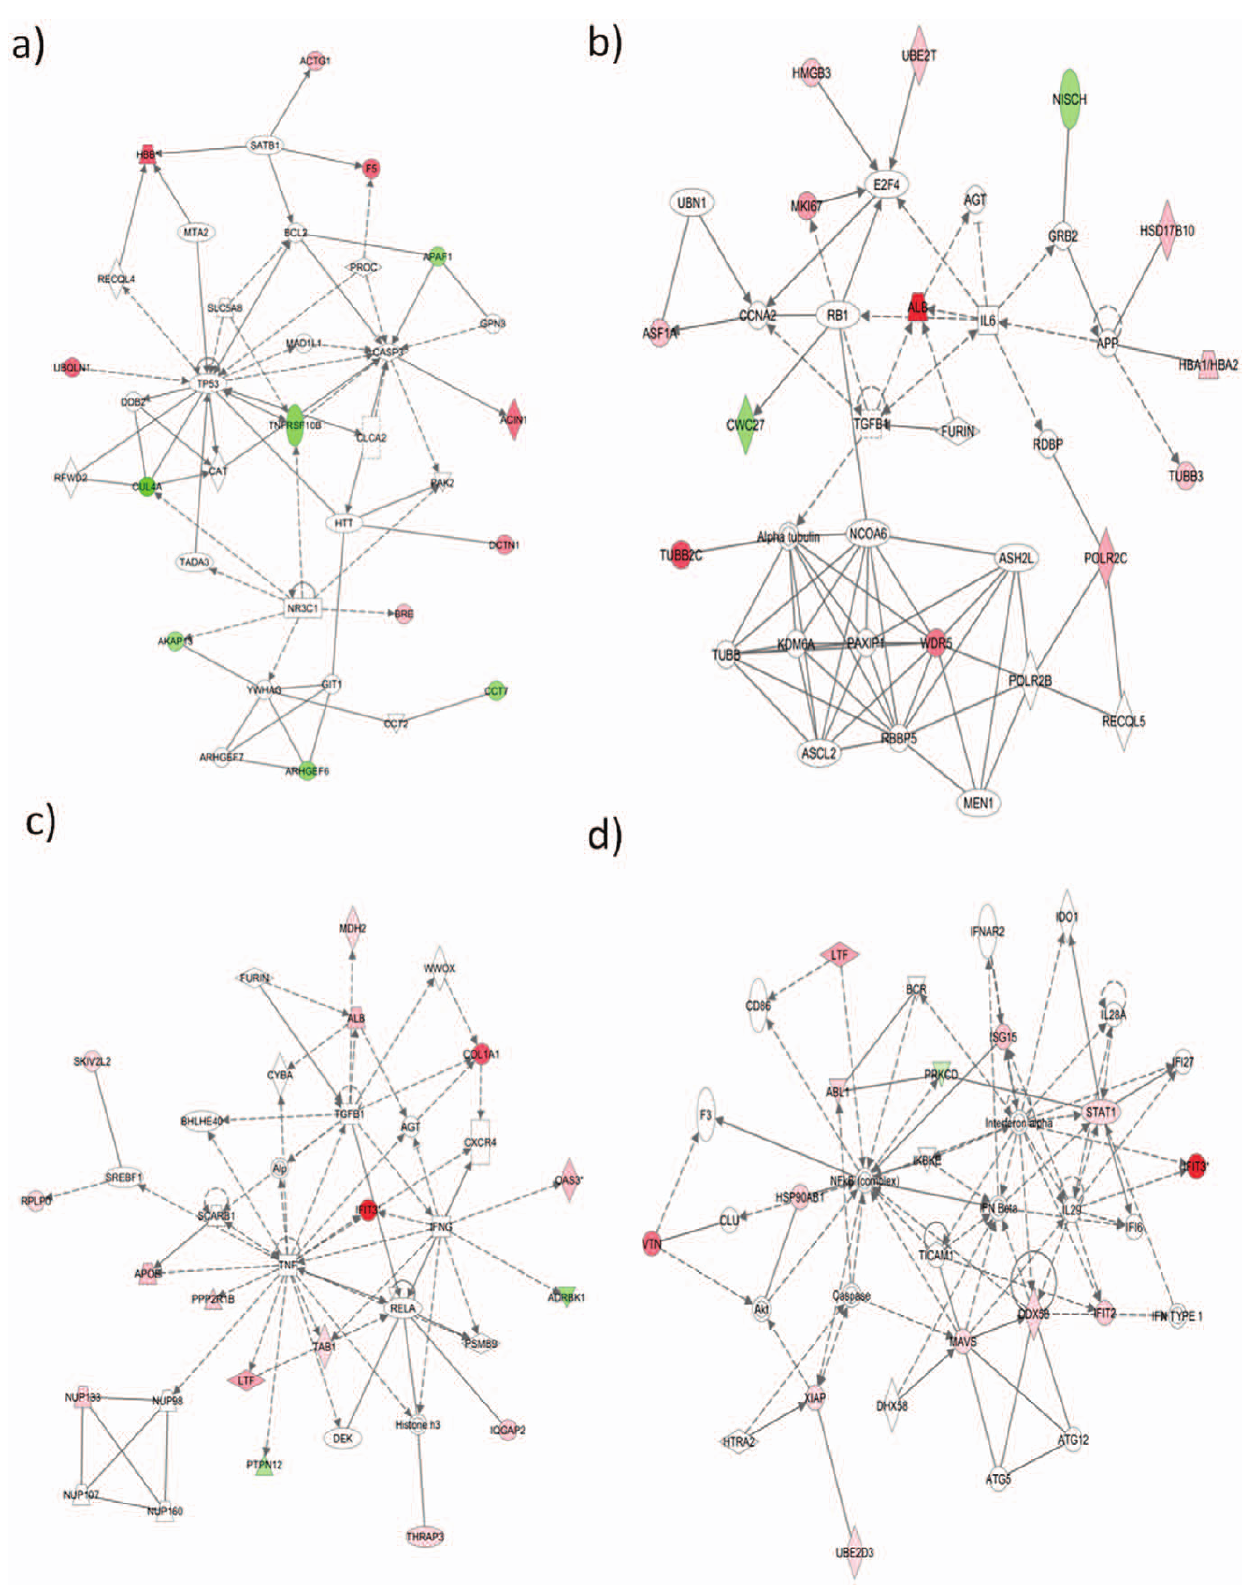
Figure 6. Functional network analysis of differentially regulated proteins observed in T1L infected HEK293 cells at 6hpi (a, b) and 24hpi (c, d). The top network functions identified in the previous figure are shown in more detail with interconnecting protein relationships indicated by solid (direct interaction) or dashed (indirect interaction) lines. Red/pink molecules represent proteins up-regulated; green molecules